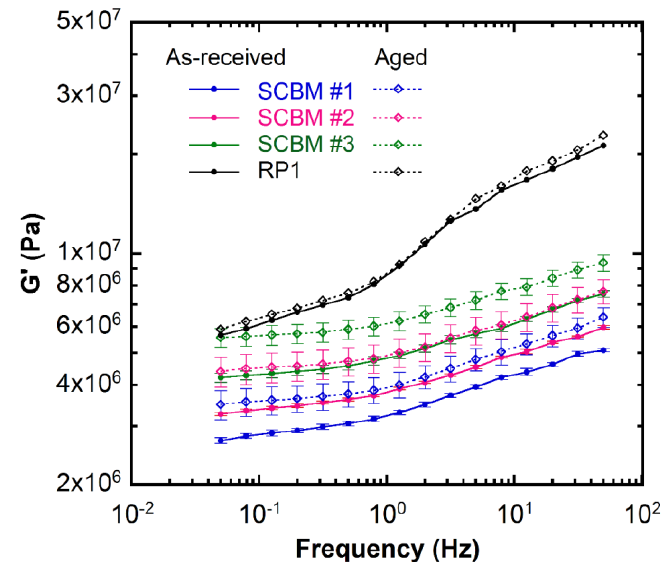
Figure 5. Dynamic shear storage modulus ( G ’) as a function of frequency measured at 25 °C for the as-received (solid circle • ) and aged (open diamond ) materials. The lines are guides for the eye. The error bars represent standard deviations of the mean from three separate measurements on different samples. View in color for best clarity.